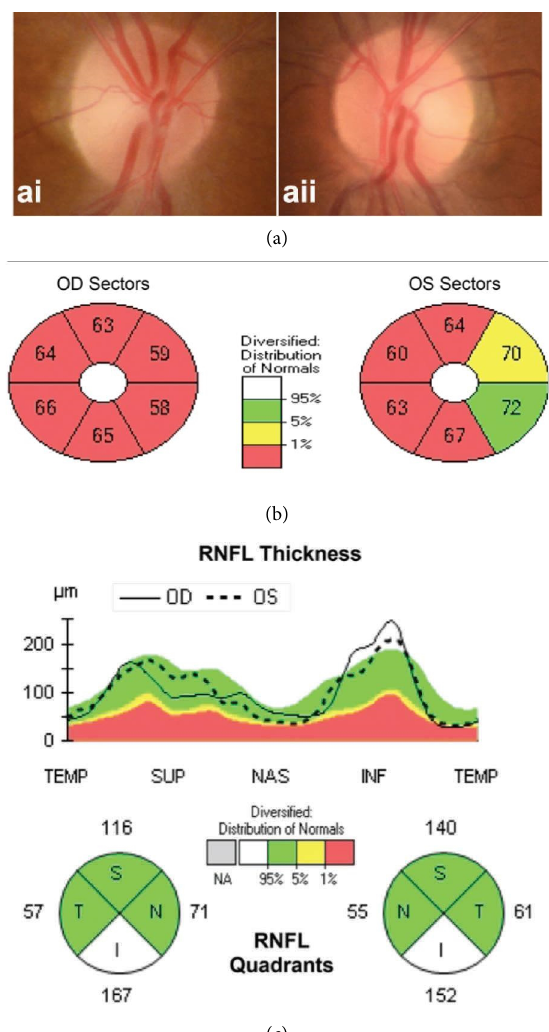
Figure 4: Te pRNFL slightly increased, but mGCL-IPL decreased early in methanol-induced optic neuropathy. (a) (i, ii) the optic nerve is normal in the fundus photograph. (b) OCT identifed obvious mGCL+IPL thinning. (c) OCT identifed mild pRNFL